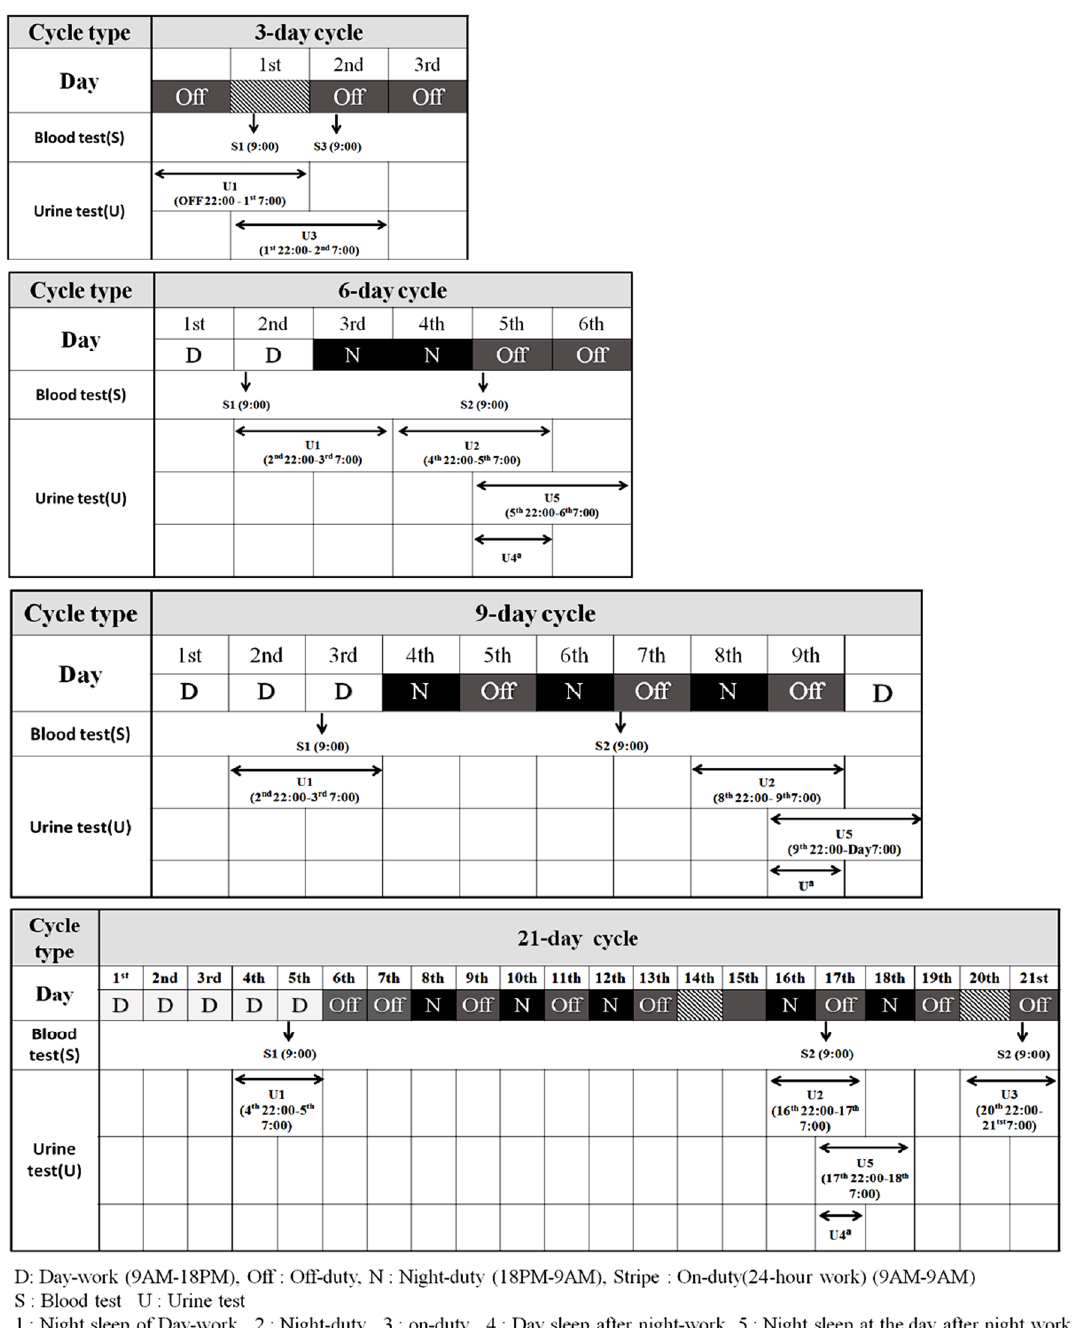
Figure B1 . The work schedule by shift cycle. Figure A1. The work schedule by shift